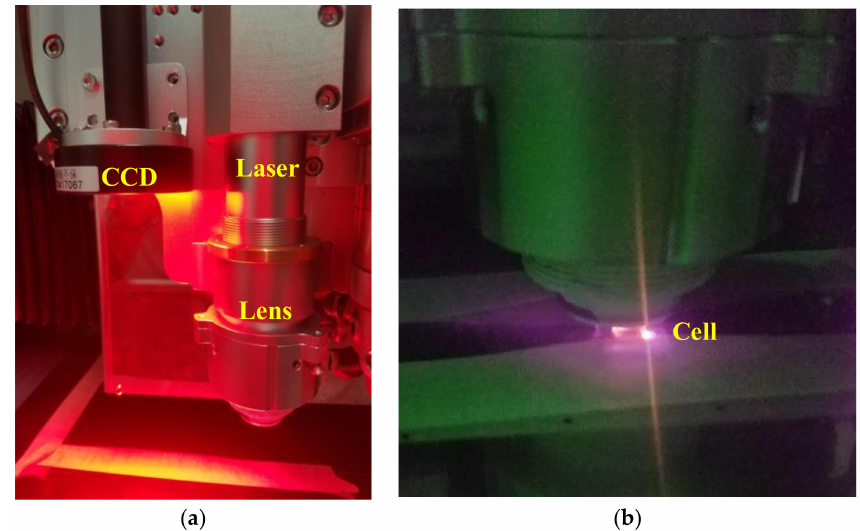
Figure 4. ( a ) Photo of rubidium dispenser activation setup with a laser, a lens and a charge coupled device (CCD); ( b ) Zoom-in photo of rubidium dispenser activation process.